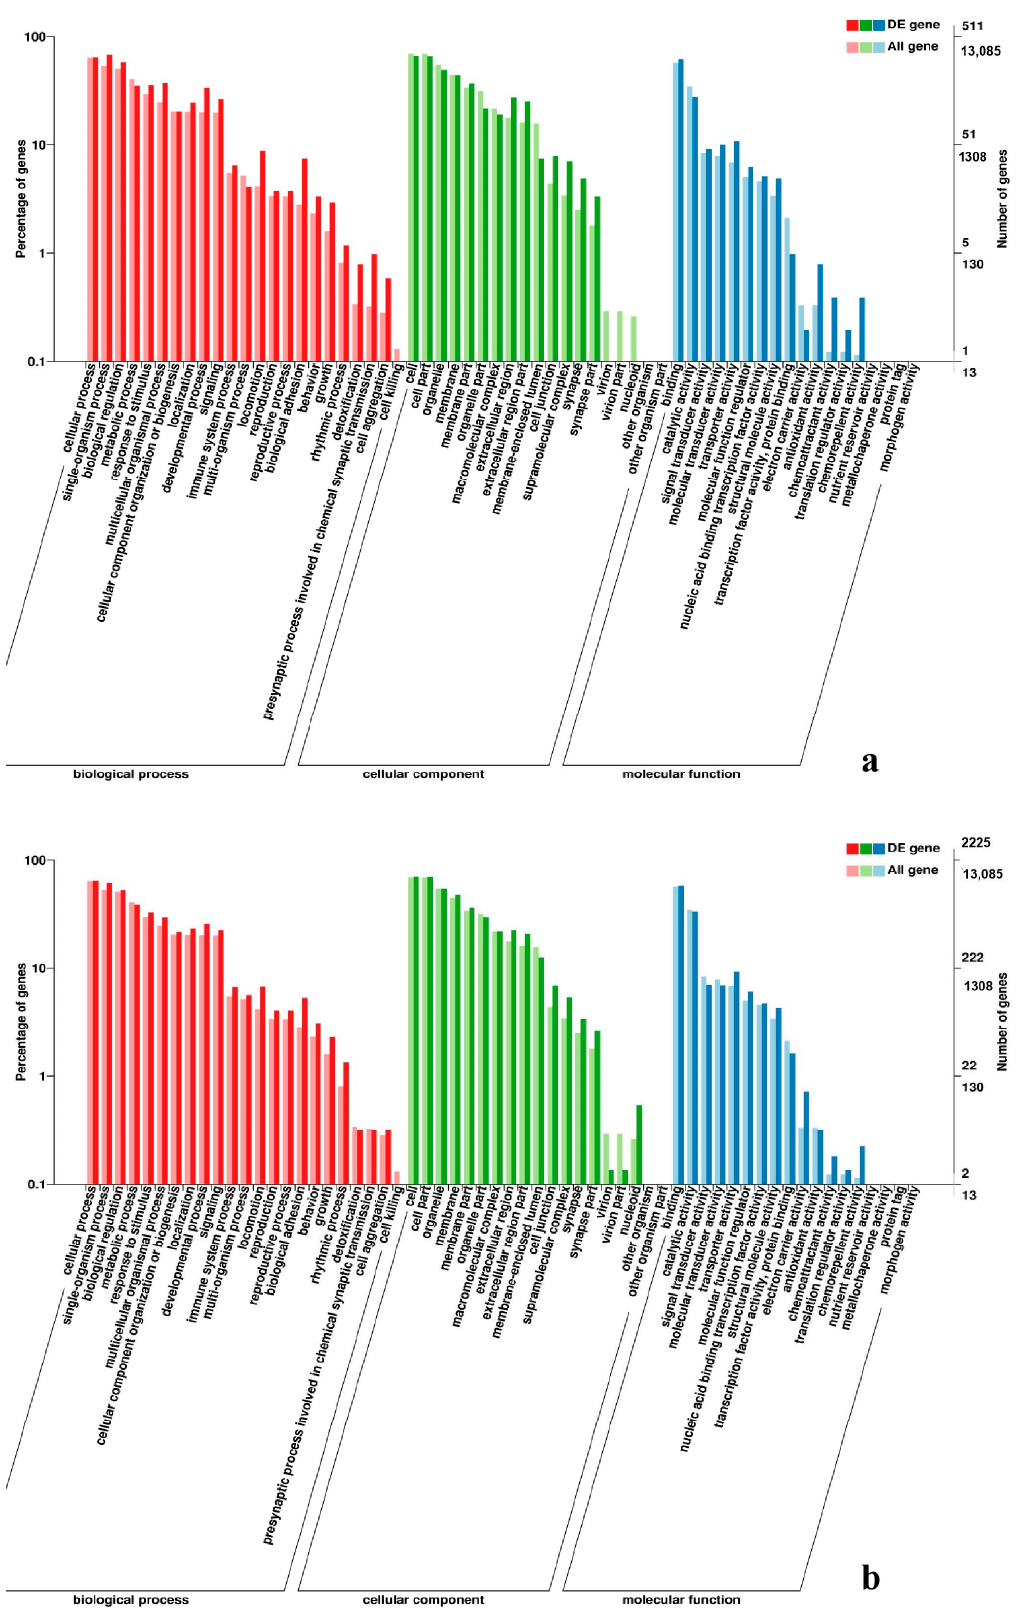
Figure 6. GO enrichment analysis of DEGs in leg muscle. ( a ) BE17L_vs_BE21L; ( b ) 6